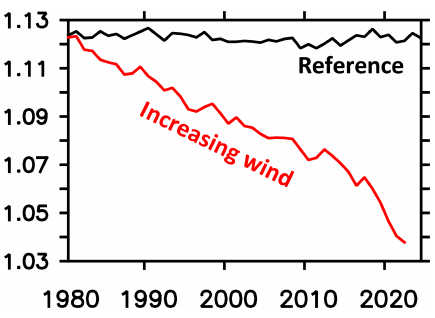
Figure 23. Simulated (dashed line, reference simulation) and ob- served (solid line, reanalysis from NSIDC) climatological annual cycle of sea ice cover south of 40 ◦ S in units of 10 7 km 2